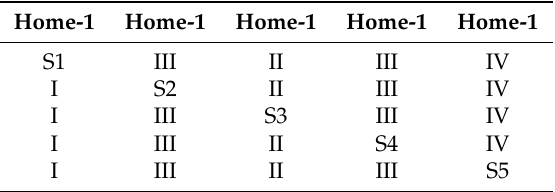
Table 8. The Bayesian game results in the